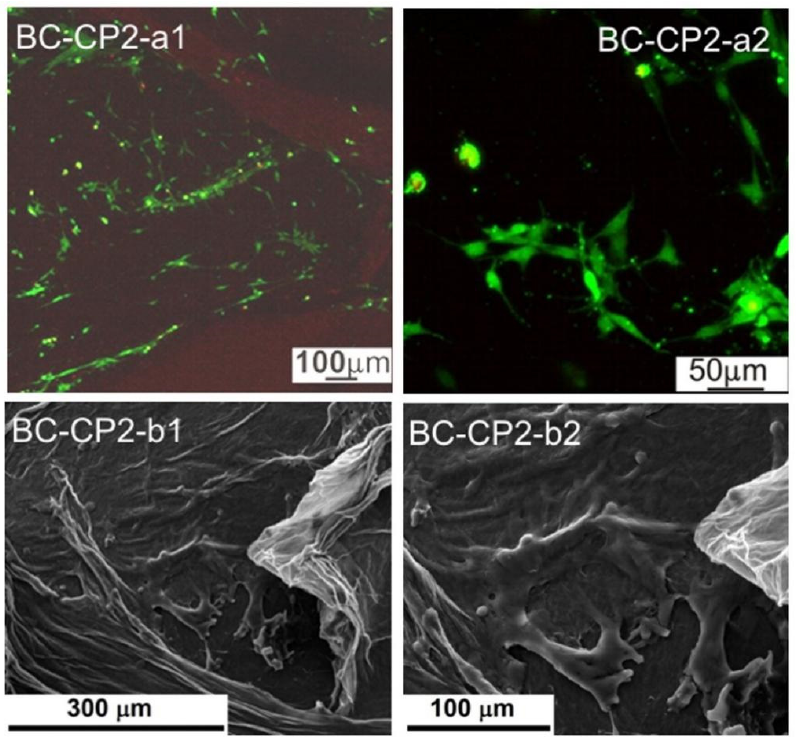
Figure 11. Fluorescence microscopy images ( a1 , a2 ) and SEM images ( b1 , b2 ) of the adherent cells in a BC-CP2 sample.